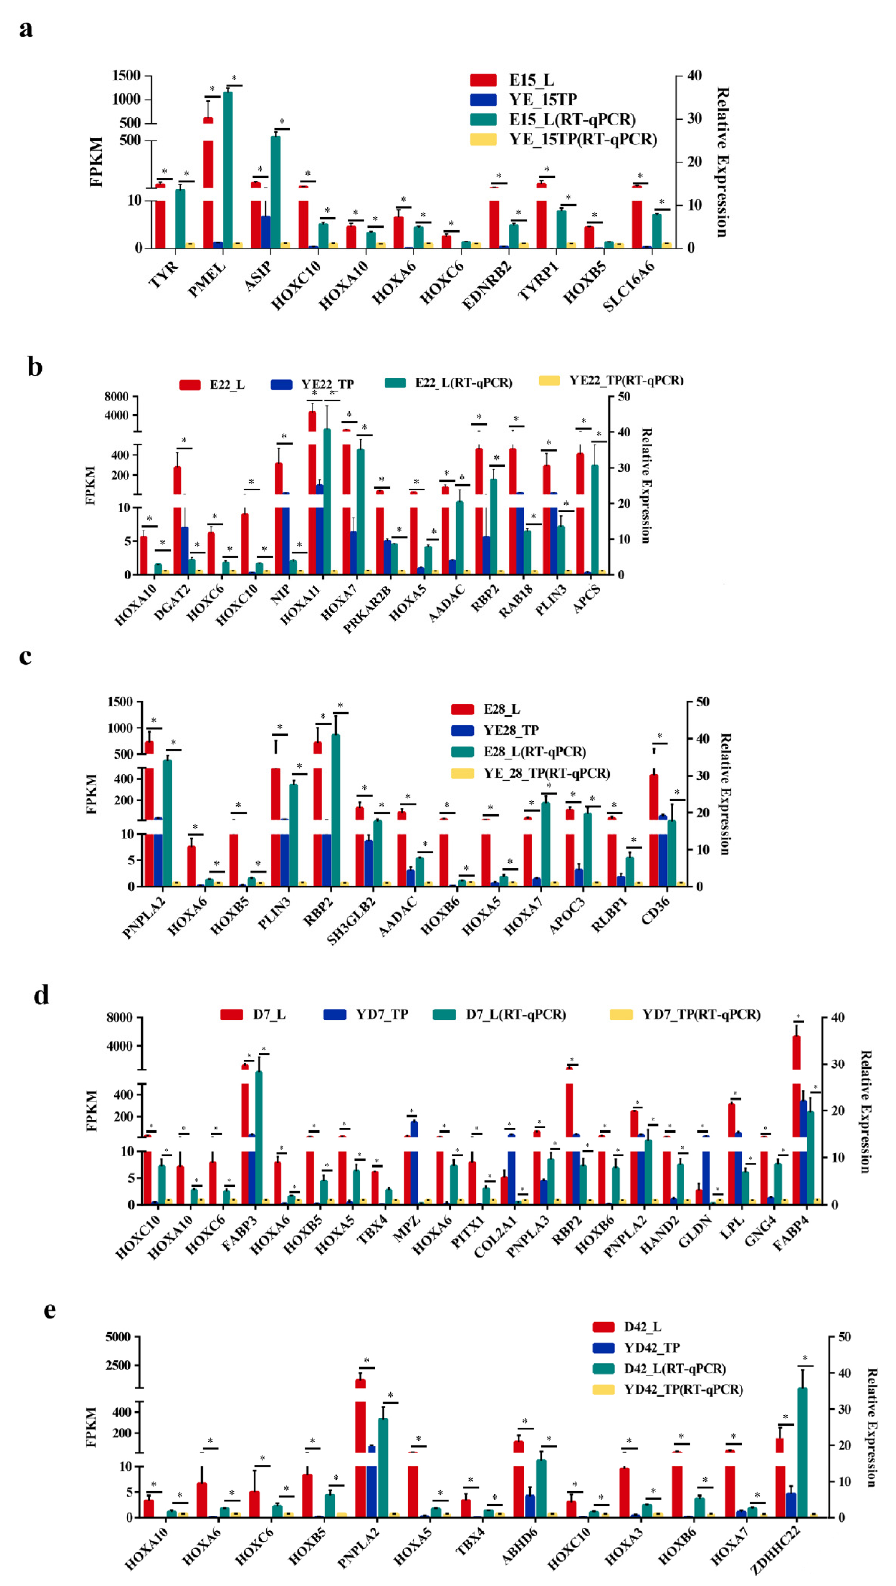
Figure 6. Validation of genes associated with crest cushion. Expression level of genes associated with crest cushion at the E15 ( a ), E22 ( b ), E28 ( c ), D7 ( d ), and D42 ( e ) stages. * Represents significant difference ( p -value < 0.05).